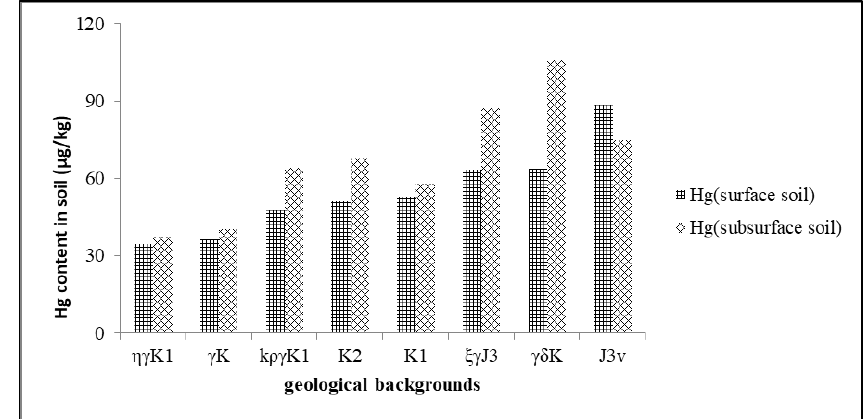
Figure 5. Comparison of Hg contents in soil with different geological backgrounds.